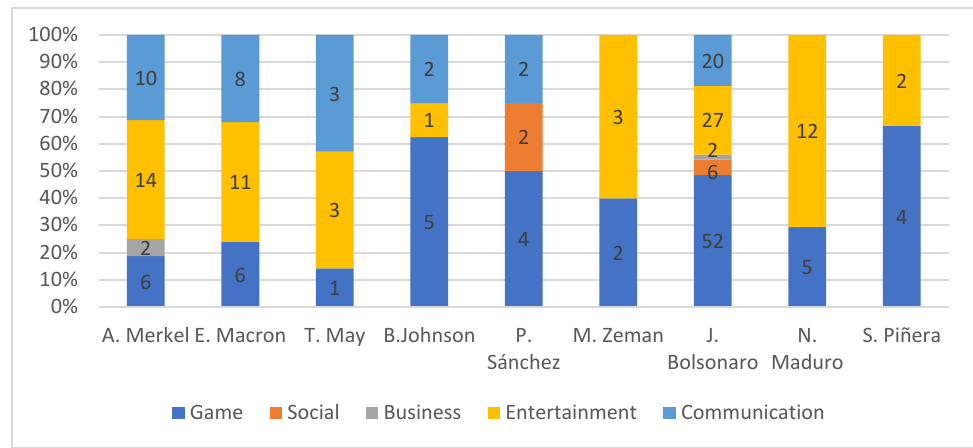
Figure 2. Classification by categories according to platforms. Source: own elaboration.